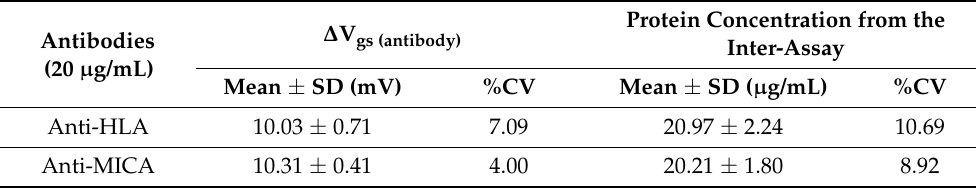
Table 2. The reproducibility of the ISFET-based biosensor for anti-HLA and -MICA antibodies